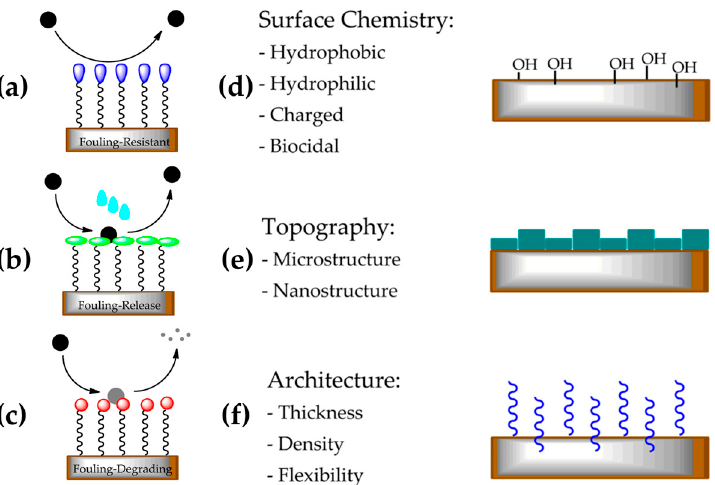
Figure 17. The three main antifouling strategies are shown schematically as preventing foulants from adhering to the surface (fouling-resistant) ( a ), reducing foulant interaction with the surface (fouling-release) ( b ), and degrading or eliminating bio-foulants (fouling-degrading) ( c ). Methods for giving a surface antifouling characteristics, including changing the surface chemistry ( d ), changing the surface topography ( e ), changing the coating design ( f ). Reproduced from MDPI Ref. [167]. In the next paragraphs, two main approaches of antifouling (AF) and fouling release (FR) (Figure 18) coating preparation will be explored, including the change in surface topography/hydrophilicity and the use of eco-friendly biocidal agents.